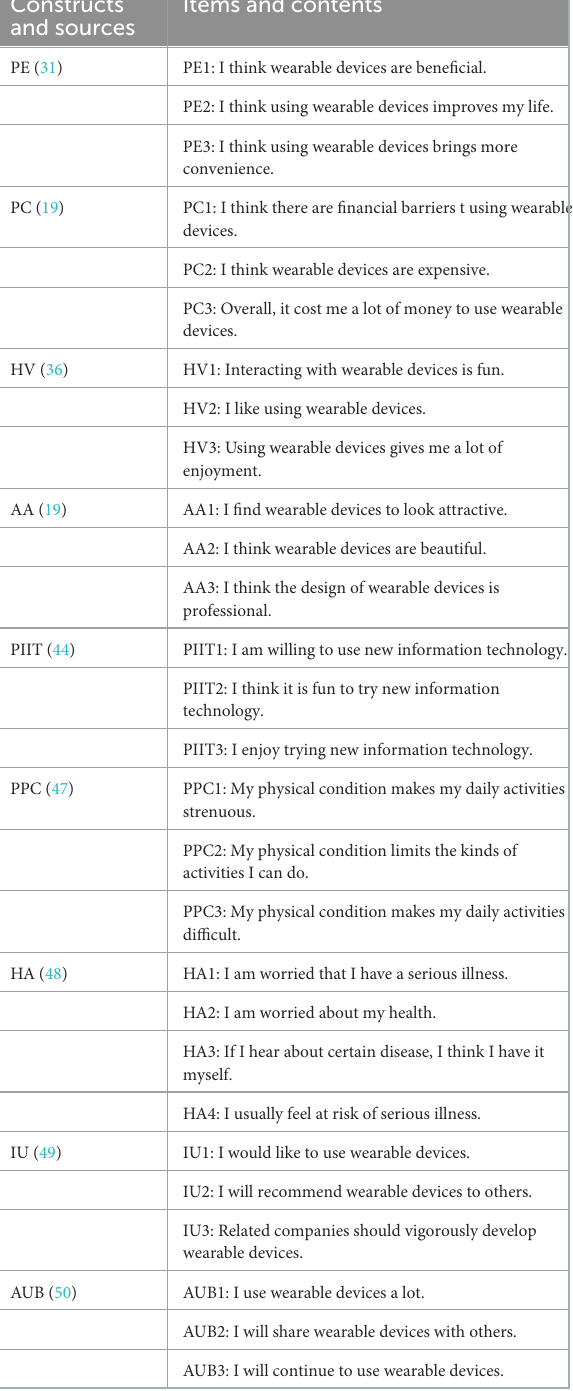
TABLE 2 Items and contents of measurement